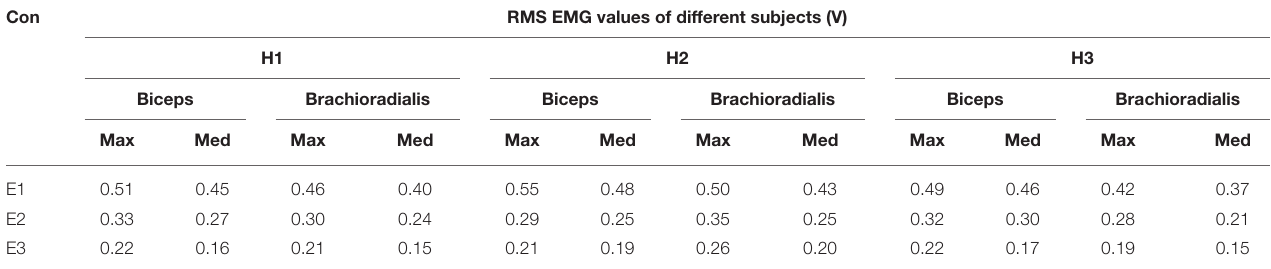
Biceps Brachioradialis Biceps Brachioradialis Biceps